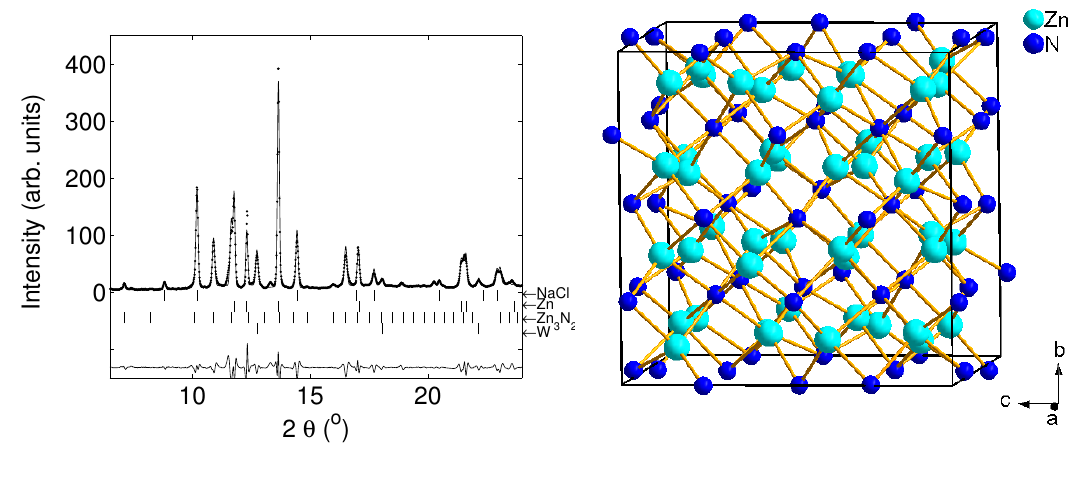
Figure 3. Left: Zn was loaded with nitrogen as reactant and pressure-transmitting medium and with NaCl for insulation in a DAC and compressed up to 10 and 24 GPa. After subsequent laser heating Zn N was synthesized. The diffraction pattern was measured after 3 2 pressure release at 0.8 GPa ( λ = 0.4958 ˚A). Diffraction lines of tungsten stem from the gasket. Right: Crystal structure of Zn N ( Ia ¯3 ) consisting of edge-sharing ZnN 3 2